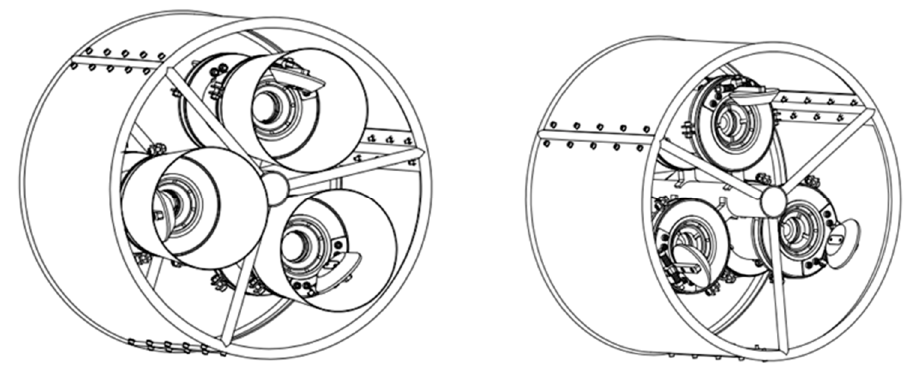
Figure 7. Schematic diagram of the sample collection cylinder structure.